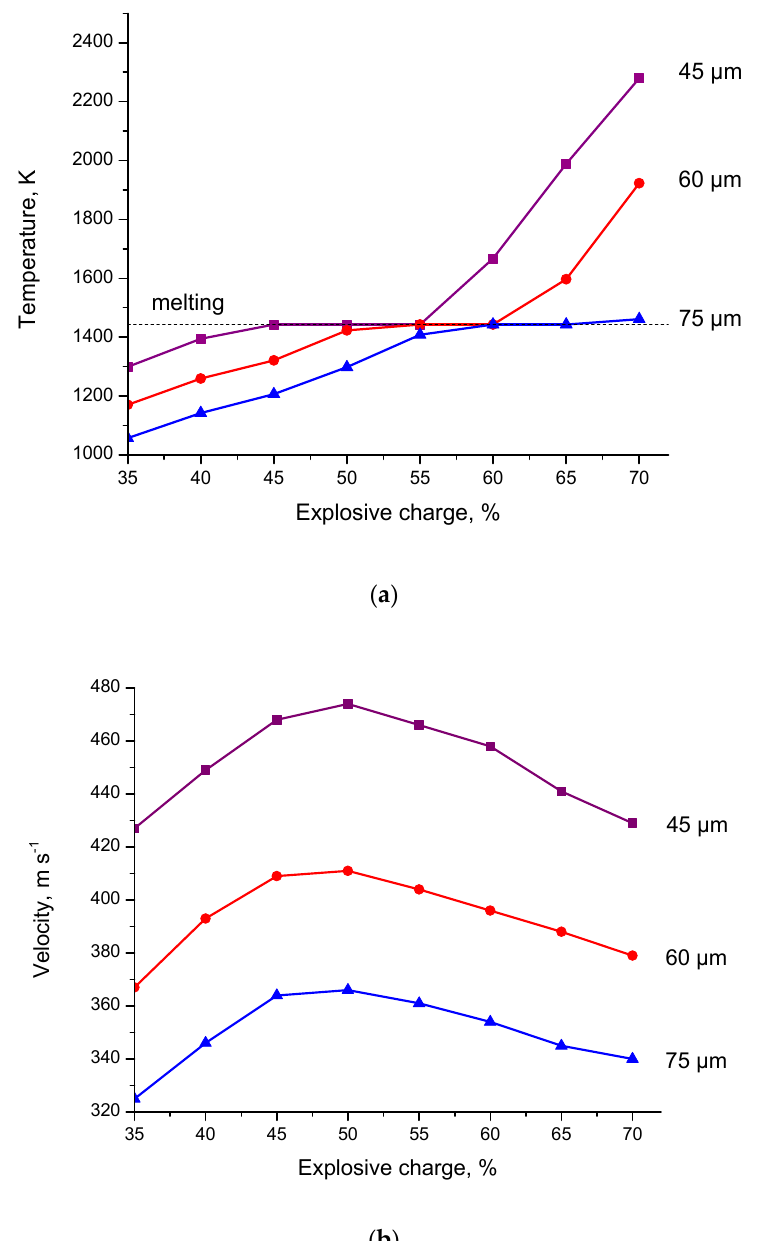
Figure 9. Calculated temperatures ( a ) and velocities ( b ) of Fe 66 Cr 10 Nb 5 B 19 particles as functions of explosive charge. Calculations were conducted for particles 45, 60, and 75 µm in diameter. It was assumed that the material melts at 1442 K (horizontal sections of the curves in (a)).